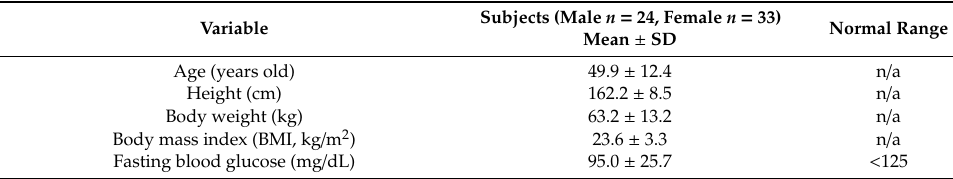
Table 1. Baseline characteristics of 57 healthy